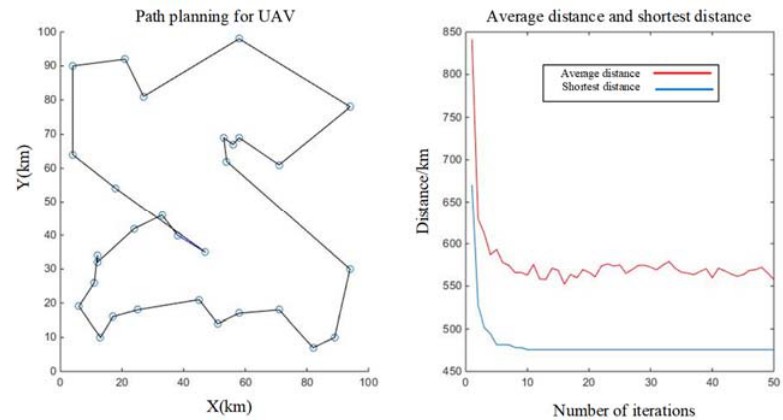
Figure 6. The result of path planning when the number of ant colonies is 30.